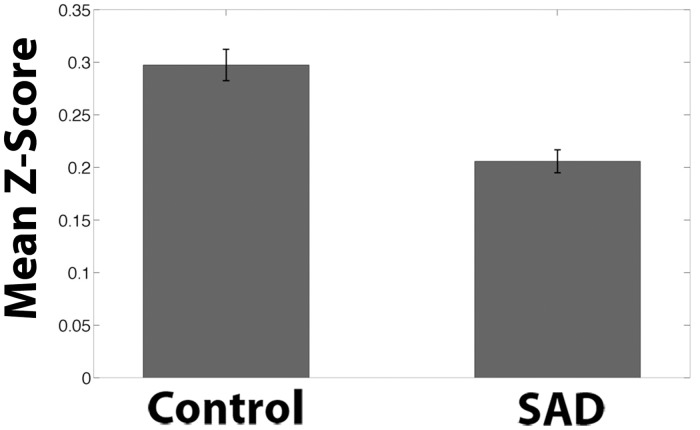
Ventromedial Prefrontal Cortex Seed Functional Connectivity Network Z-Scores of Control > SAD.Mean Fisher transformed correlation values for resting-state connectivity for clusters from Fig 5B showing significant difference for Control group > SAD group with ventromedial prefrontal cortex seed from Fig 6A. Bars represent the mean connectivity for each group for the medial prefrontal cluster from Fig 6B. Peak voxel Cluster 1 (MNI coordinates): (-12, 20, -20). One-sample t-test relative to 0: Control: p < .0001. SAD p < .0001. Error bars represent standard errors.